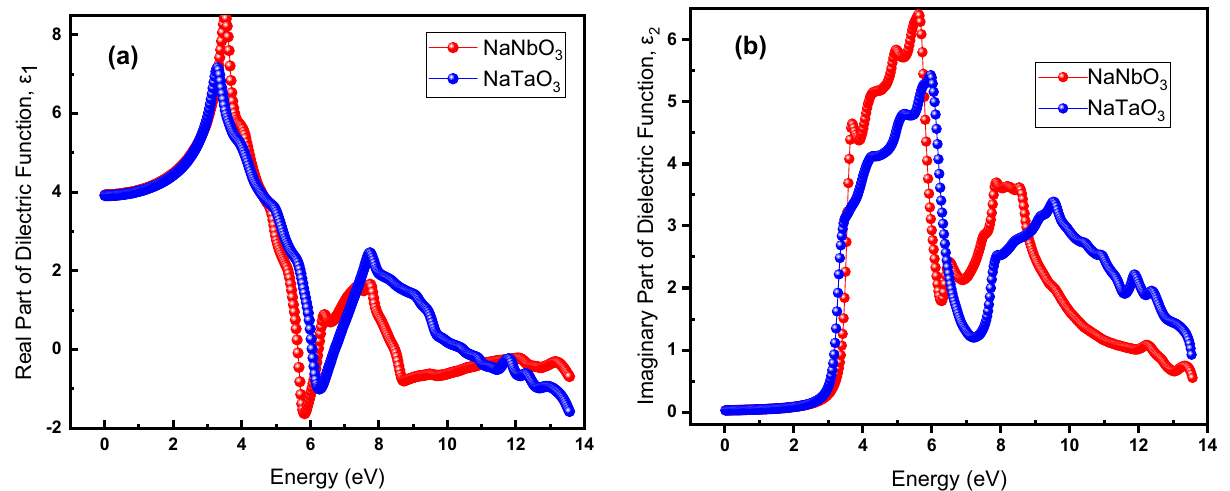
Figure 7. (Color Online) ( a ) real and ( b ) imaginary parts of dielectric function for NaNbO 3 (red) and NaTaO 3 oxide